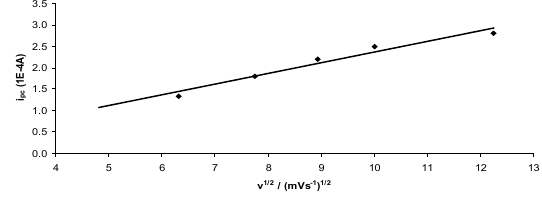
as a function of the scan rate.